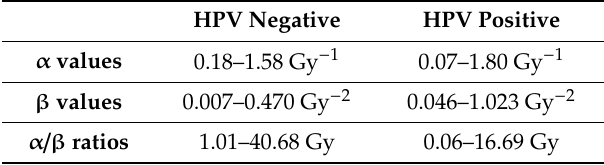
Table 2. Range of α and β values and α / β ratios by HPV status over 4